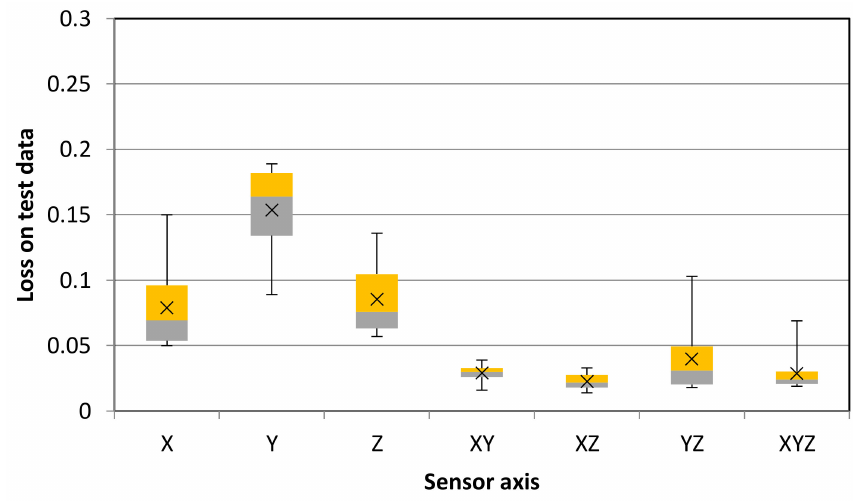
Figure 28. Box plot of ‘loss on test data’ for all sensor axis of the dynamometer.